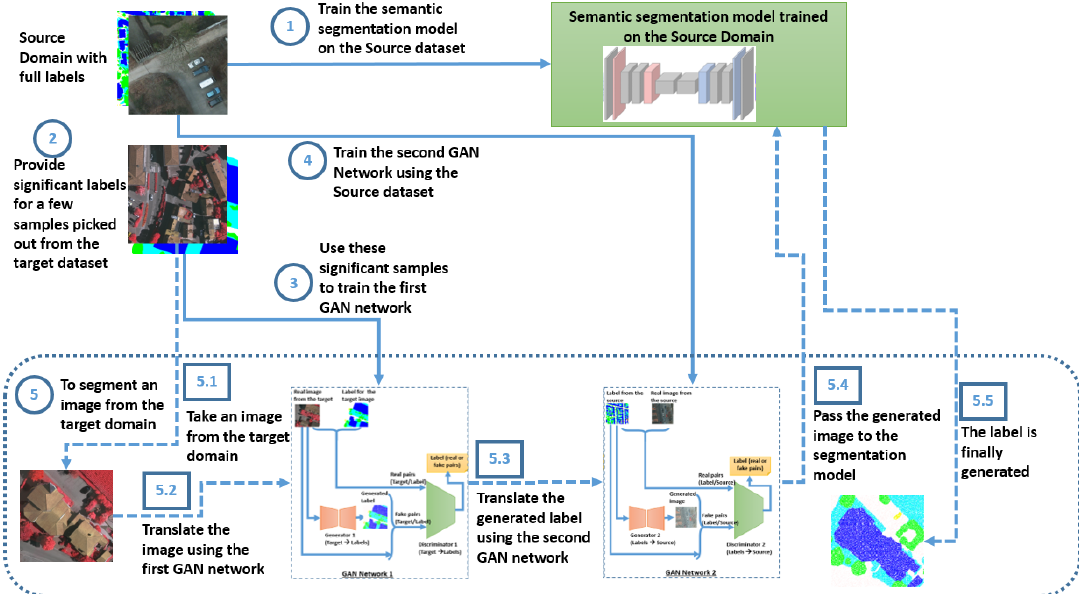
Figure 5. Flowchart of the domain adaptation